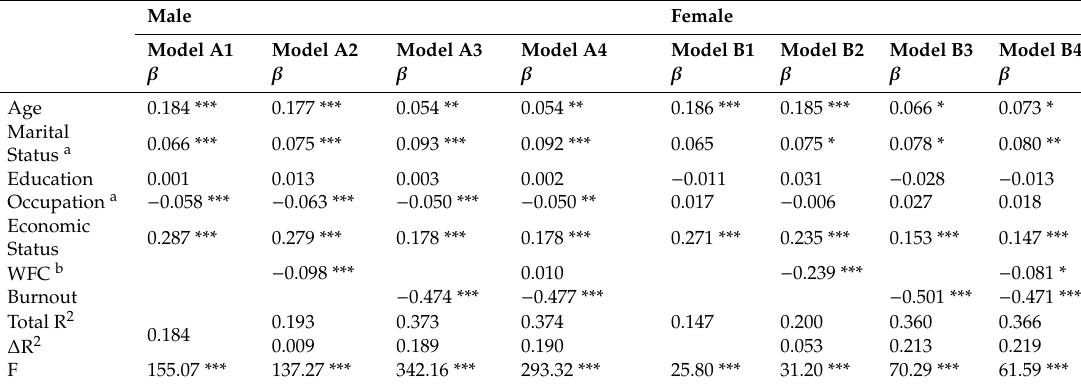
Table 3. Summary of multiple linear regressions predicting the well-being for male and female